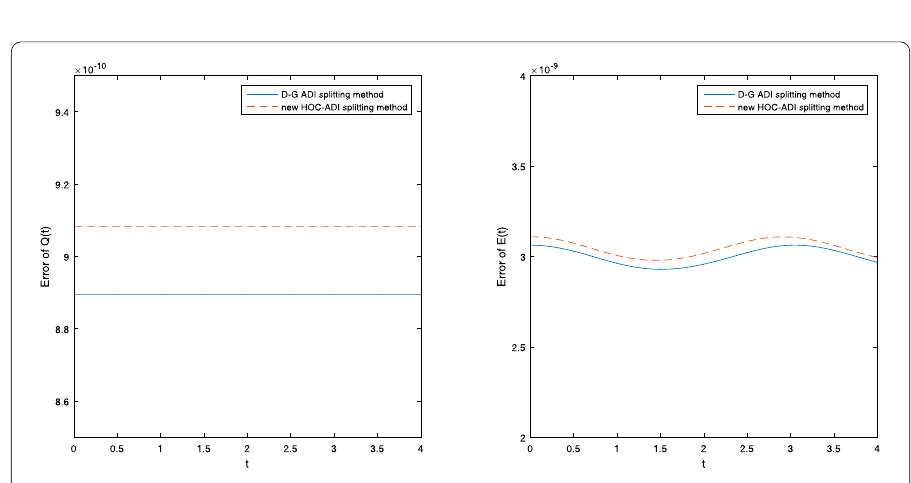
Figure 6 Discrete conservation errors using two methods for Example 2 under τ = 0.005, h = 2 π /25